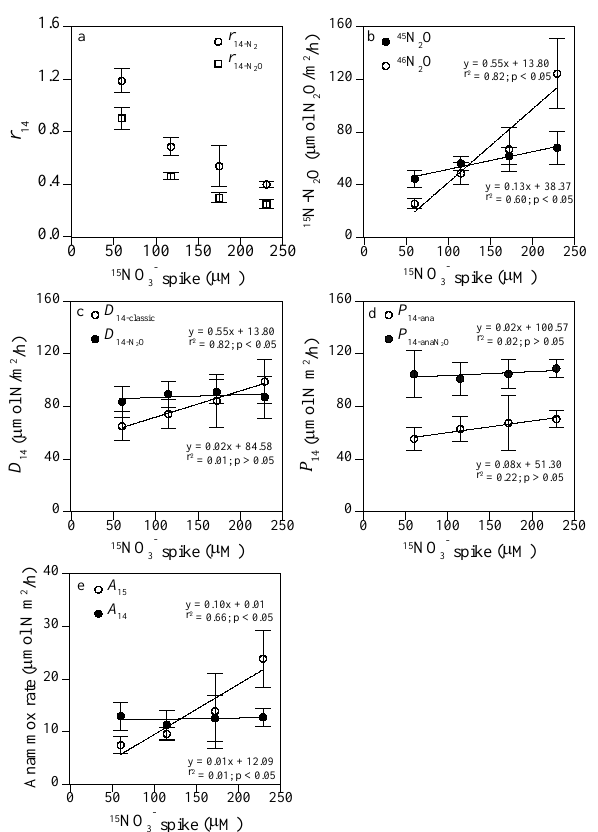
Fig. 7. Results from concentration series experiment. (a) r 14 as a Figure 7. Results from concentration series experiment. (a) r 14 as a function of 15 NO 3- 939 function of 15 NO − spike, (b) production of 15 N 2 O as a function of 3 15 NO − spike, (c) comparison of denitrification N 2 production rates spike; (b) production of 15 N 2 O as a function of 15 NO 3- spike; (c) comparison of 940 3 estimated by IPT classic ( D 14 − classic ) and IPT N ( D 14 − N ), (d) 2 O 2 O denitrification N 2 production rates estimated by IPT classic ( D 14-classic ) and IPT N 941 comparison of genuine N 2 and N 2 O production rates estimated by 2 O IPT ana ( P 14 − ana ) and IPT anaN ( P 14 − anaN ) and (e) the labeled ( D 14-N ); (d) comparison of genuine N 2 and N 2 O production rates estimated by IPT ana 942 2 O 2 O 2 O ( A 15 ) and unlabeled ( A 14 ) anammox rates as a function of 15 NO − 3 spike. Values are means ± 1SEM ( n = 3). Regression analysis used individual data ( n =